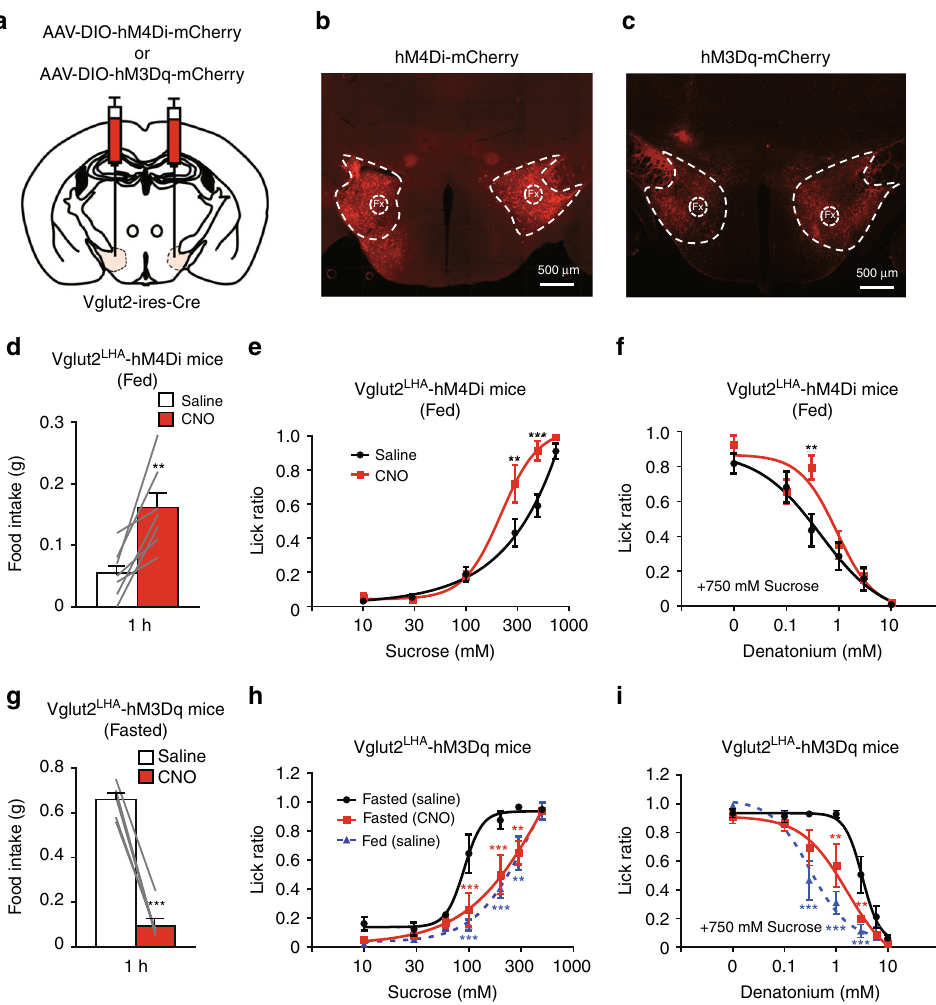
Fig. 5 Vglut2 neurons are necessary for hunger-induced modulation of taste preference. a Bilateral injection of AAV-DIO-hM4Di-mCherry or AAV-DIO- hM3Dq-mCherry into the LHA of Vglut2-ires-Cre mice. b – c Representative images of hM4Di-mCherry ( b ) and hM3Dq-mCherry ( c ) expression in Vglut2 LHA neurons. Fx, fornix. d Chemogenetic inhibition (CNO 1.0 mg/kg i.p.) of Vglut2 neurons in the LHA promotes food intake in Vglut2-hM4Di mice within 1 h n = 7, paired Student ’ s t test. e – f Brief access tests with sweet ( e ) and bitter ( f ) taste solutions in Vglut2 LHA -hM4Di mice in the presence or absence of CNO (1.0 mg/kg i.p.). n = 6, F = 11.99, and P = 0.001 in e and n = 6, F = 5.37, and P = 0.023 in f , two-way ANOVA with Bonferroni post